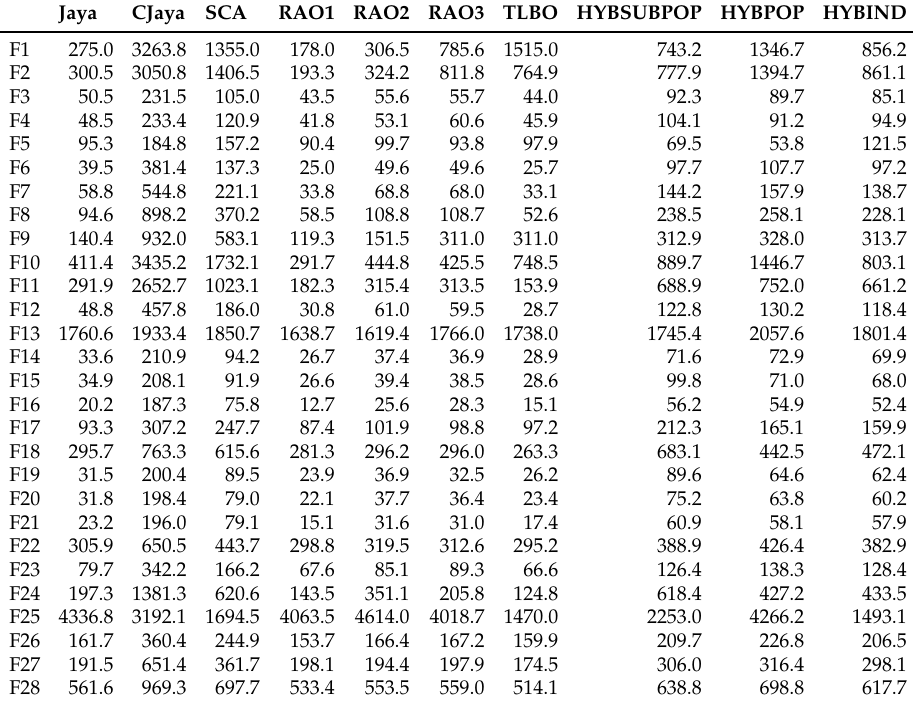
Figure 2. Convergence curves. The population size is set as 140 and the number of iterations to 100. Table 7. Computational times (s.) for 50 runs. The population size is set as 140 and max _ ITs is set to